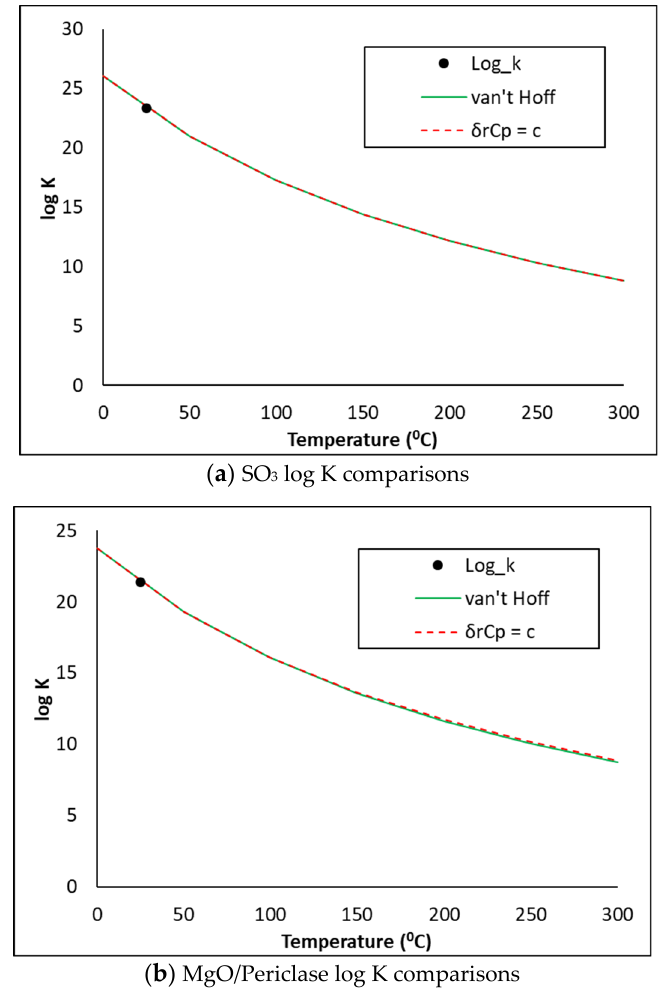
Figure 6. SO3, MgO and Periclase log K comparisons. Table 3. Thermodynamic data to derive SO 3 , MgO and Periclase phases taken from [21].